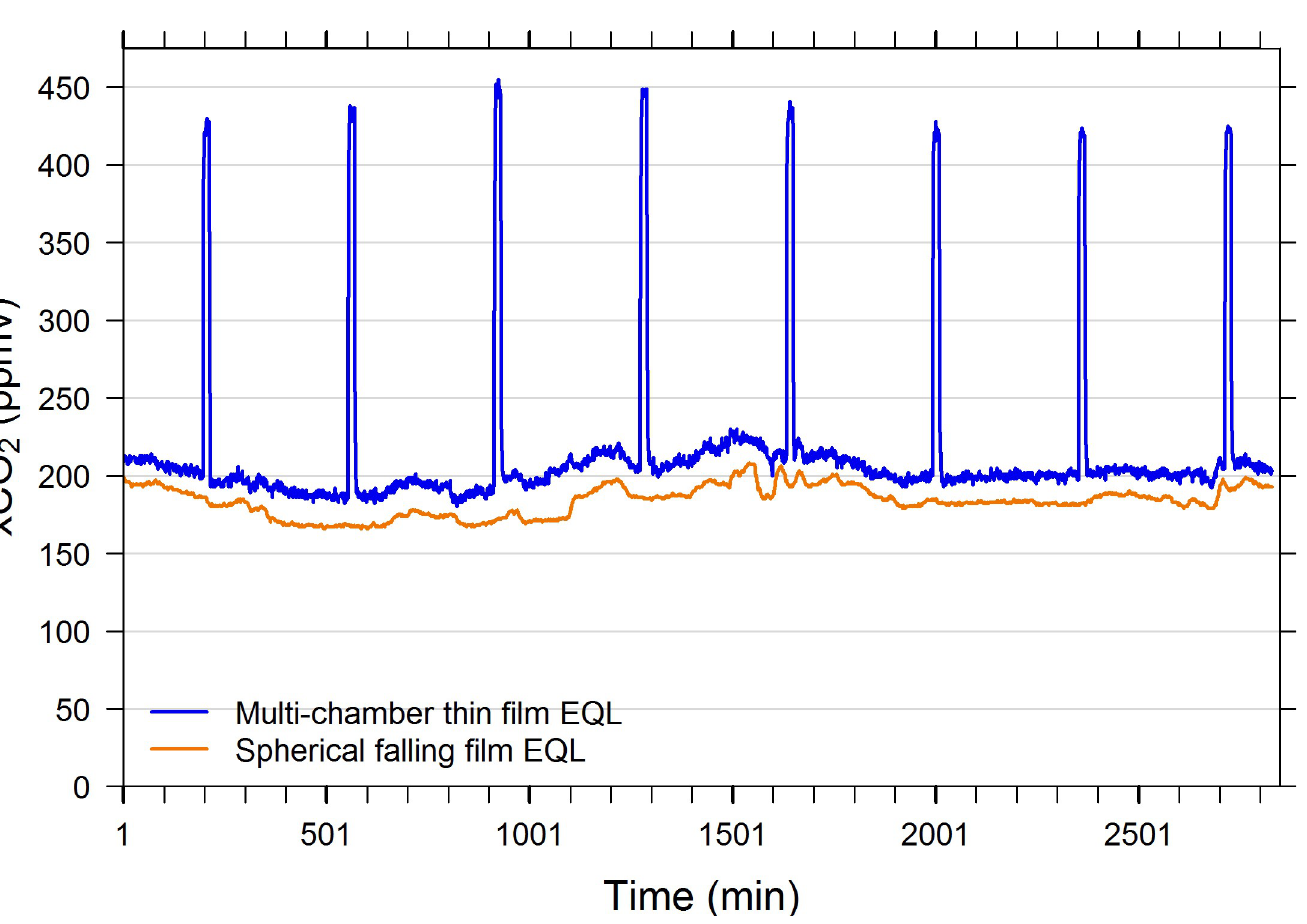
Fig 10. Side-by-side field measurements of multi-chamber thin film open loop and 8-in spherical falling film closed loop EQLs. Measurements were made autonomously at 1-min intervals February 14–16, 2017 in the Rhode River from the SERC pier, Edgewater, MD. The multi-chamber thin film EQL was programmed to sample atmospheric air for 15 mins at 6-hr intervals. The spherical falling film EQL consistently measured lower values than the multi-chamber thin film EQL throughout the time period (mean difference ± SD = -20.3 ± 20.2 ppmv, n = 2707, when readings are excluded during atmospheric readings).